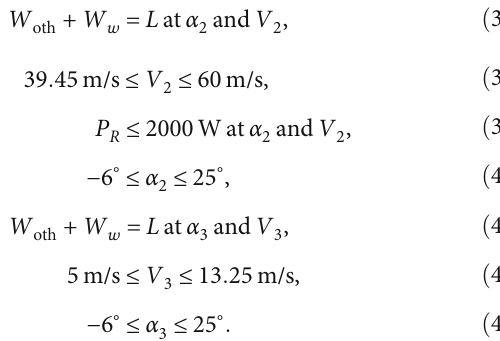
vs. V curves for the baseline UAV and the optimum R